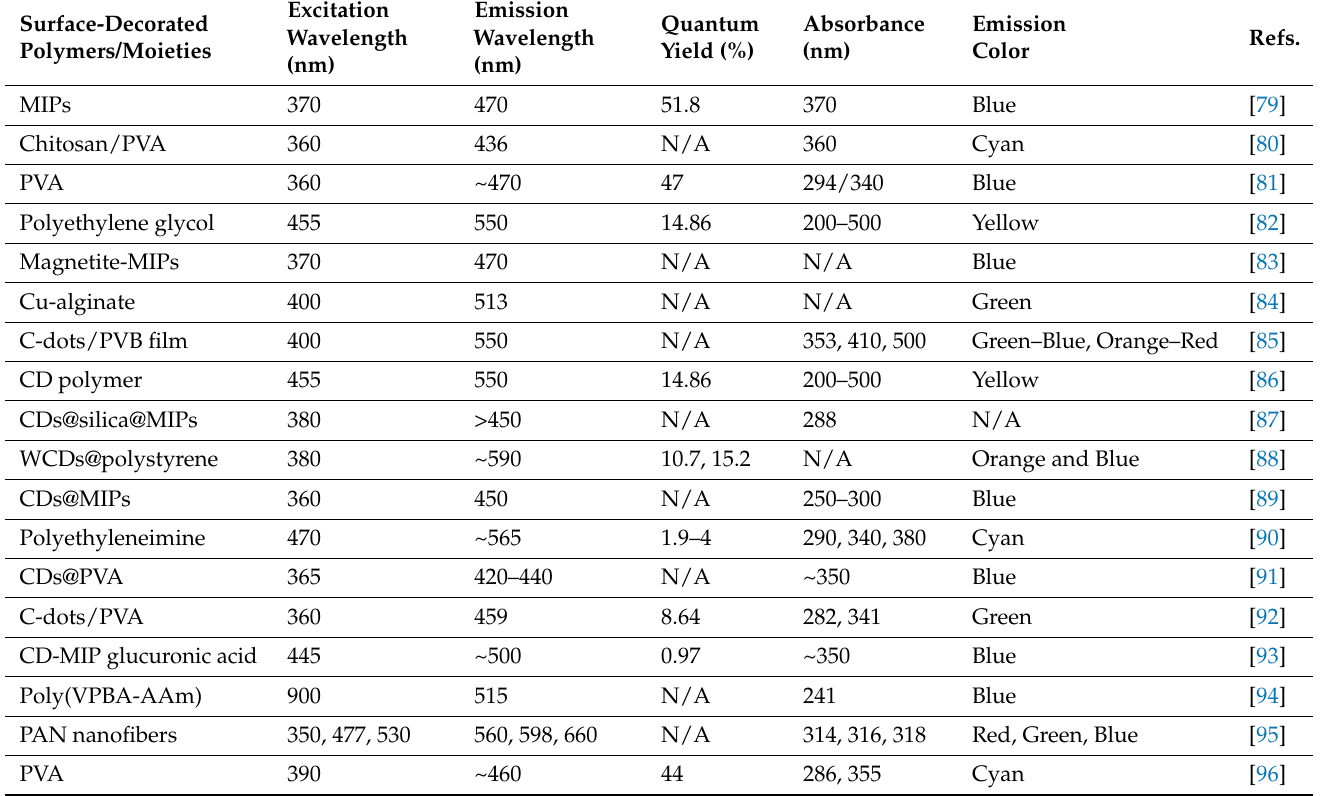
Table 1. The fluorescence (FL) and ultraviolet–visible (UV–vis) absorption characteristics of a number of different QD/polymer